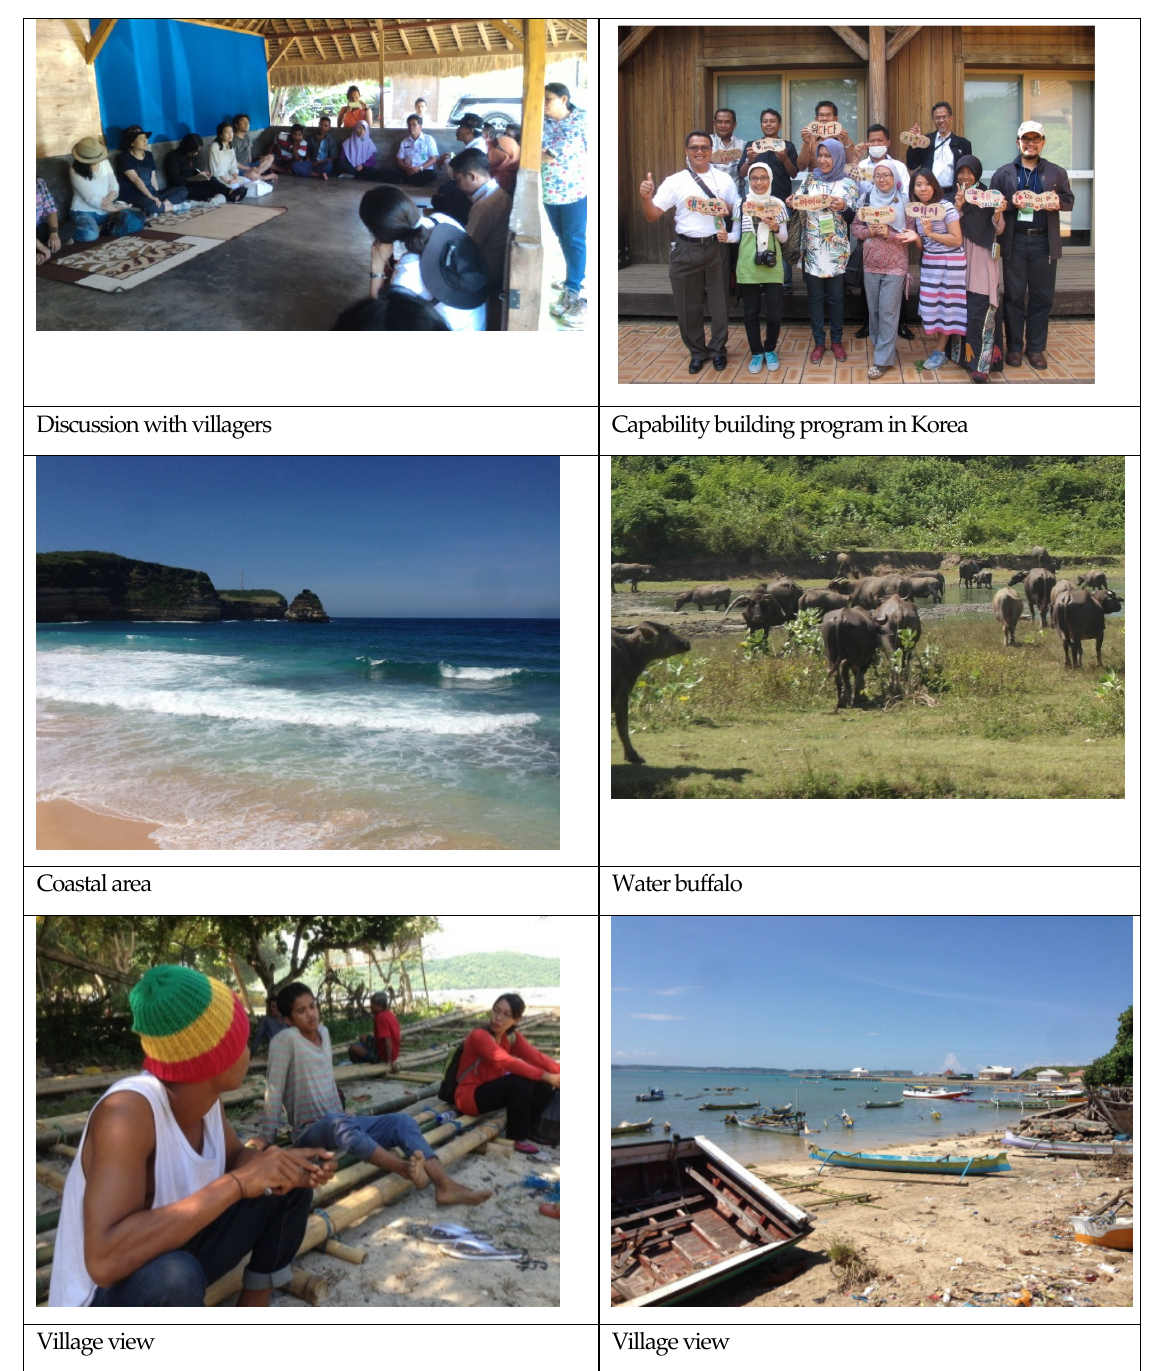
Figure 2. Images of research project, 2014–2018.